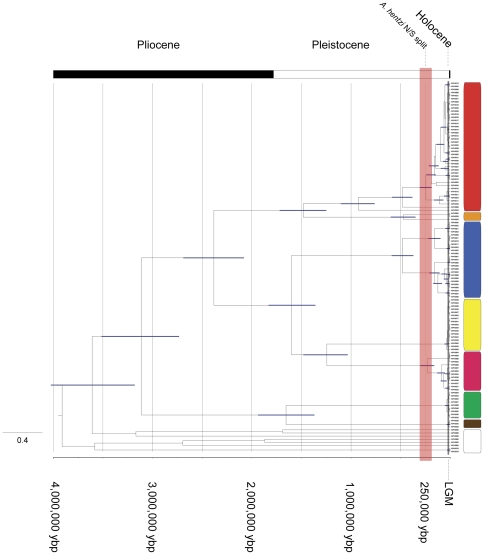
4% clock-constrained gene tree for the species of Aphonopelma found in Texas.To assign dates to population-splitting events within the A. hentzi lineage and assess the importance of these historical events on cladogenesis across the whole tree, a fixed molecular clock at 4% was applied in BEAST to evaluate how this mygalomorph rate of evolution relates to the events of the Pleistocene. Population splits within the A. hentzi clade (northern vs. southern) are predicted to have originated around 237,000 ybp (294,900−183,200), represented by the light red box. The Pliocene/Pleistocene/Holocene time frame is displayed at top, years from present on the bottom, with The Last Glacial Maximum designated by the grey box. The bars correspond to 95% confidence intervals.